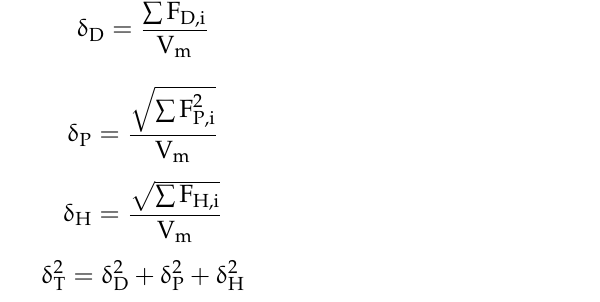
Table 2. Hansen solubility parameters of the solvents and the phenolic acids. Compound V m (mL/mol) δ